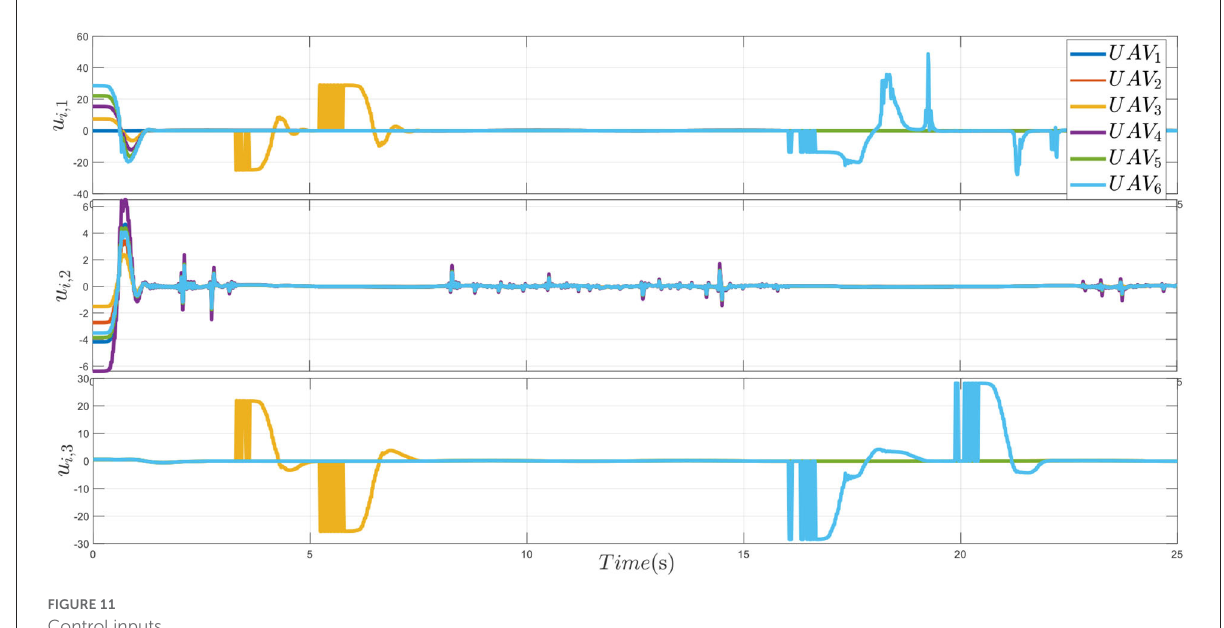
FIGURE11 Control